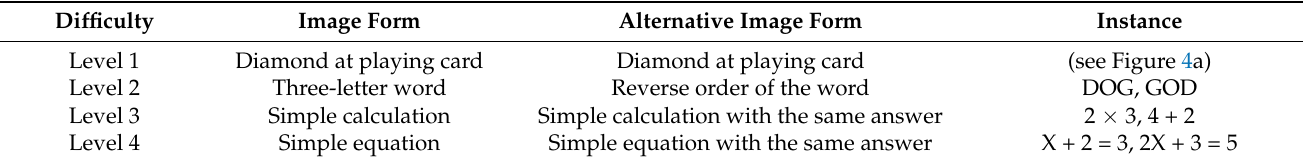
Figure 4. Interface of the primary task ( a ) and the secondary task ( b ). Table 1. Four types of images on the cards in the primary task.